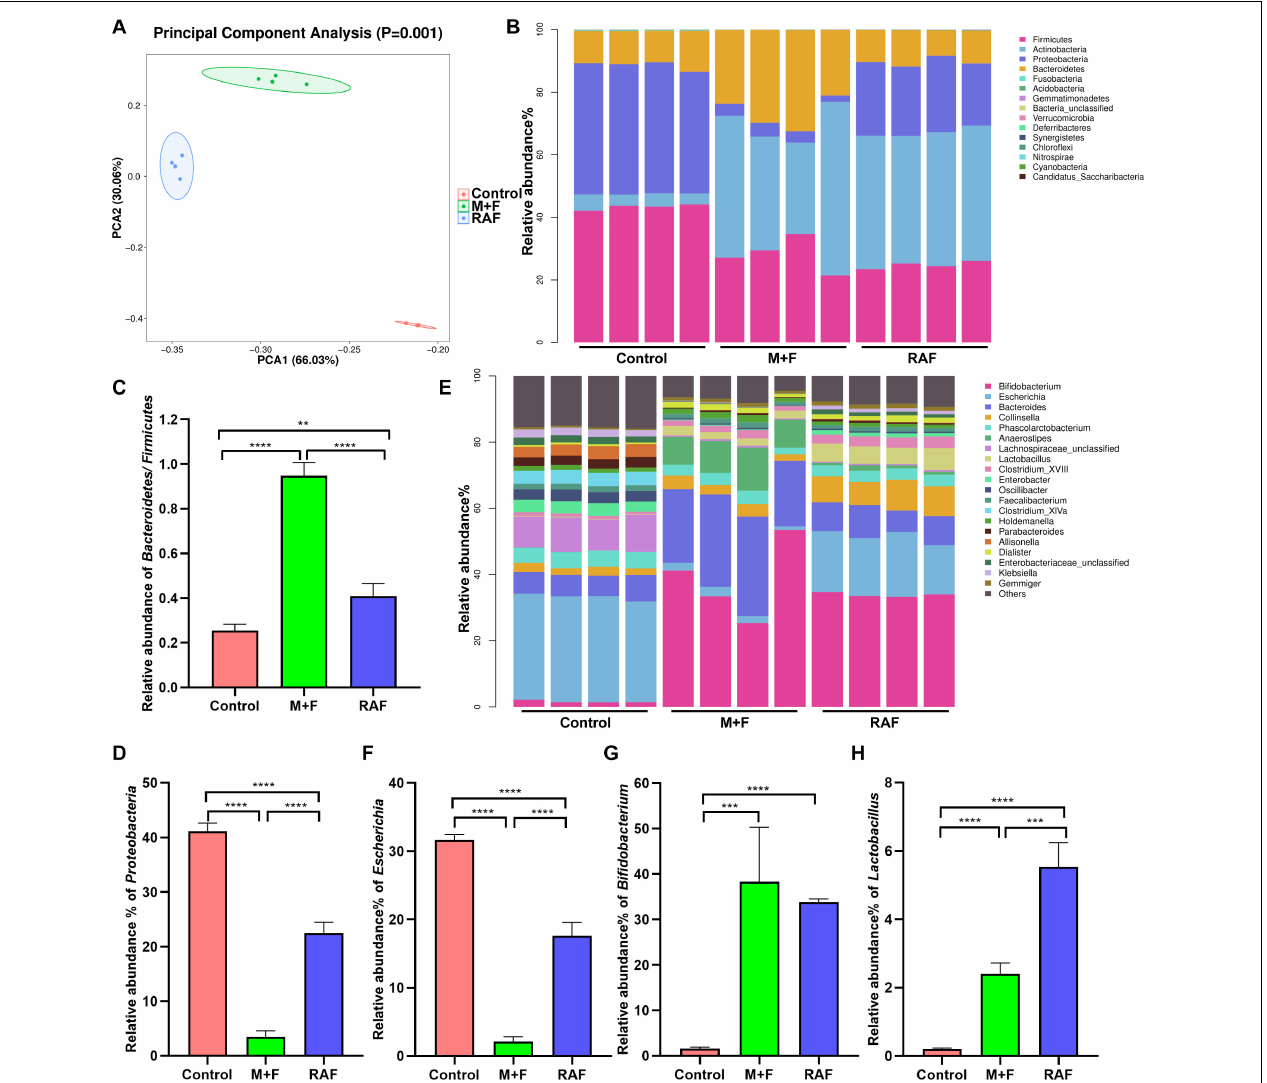
FIGURE 5 | The effects of soymilk (RAF) and InvDz13-treated soymilk (M + F) on human gut microbiota via in vitro fermentation. (A) Principal component analysis. (B) The taxonomic composition distribution at the phylum level. (C) The relative abundance of phylum Bacteroidetes to Firmicutes . (D) The relative abundance of phylum Proteobacteria . (E) The taxonomic composition distribution at the genus level. (F) The relative abundance of genus Escherichia . (G) The relative abundance of genus Bifidobacterium . (H) The relative abundance of genus Lactobacillus . The data were analyzed using student’s t - test (** P < 0.01, *** P < 0.001, and **** P < 0.0001). Data show mean ± SD, n =